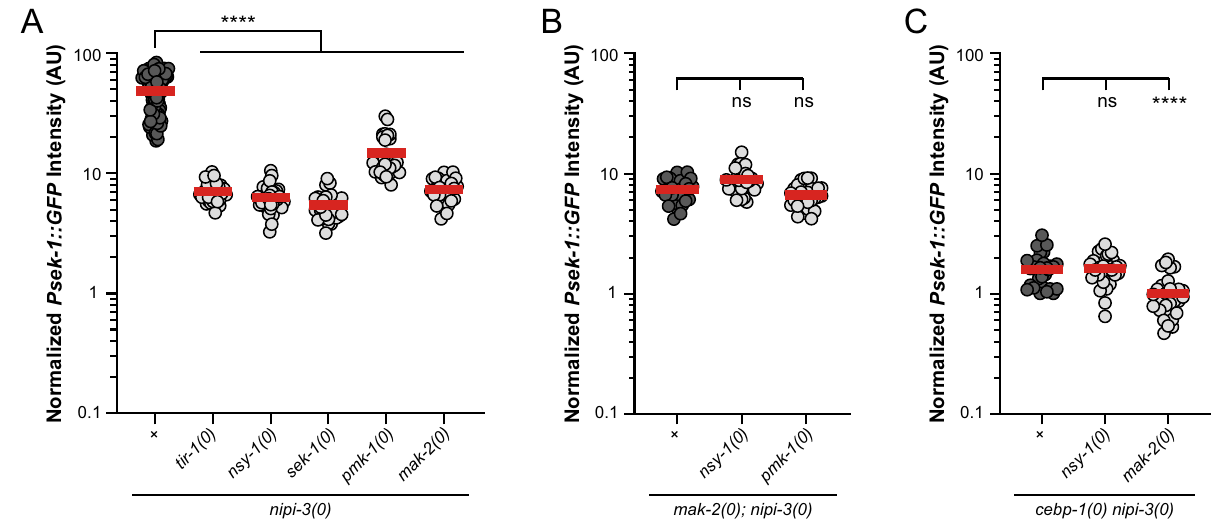
Figure 5. Transcriptional reporter of sek-1 suggests pmk-1 /MAPK and mak-2 /MAPKAPK feedback regulation of transcription of sek-1 . (A-C) Quantification of Psek-1::GFP expression in animals 36 h post egg laid. Null alleles in this figure are nipi-3(ju1293) , cebp-1(tm2807), tir-1(qd4), nsy-1(ok593), sek-1(km4), pmk-1(km25), and mak-2(ok2394) . Statistics Kruskal–Wallis one-way ANOVA with Dunn’s multiple comparisons test. ns , not significant, ** P < 0.01, **** P < 0.0001. ( A ) Knockout of nipi-3 substantially increases Psek-1::GFP expression, which is significantly reduced by null mutations to any member of this MAPK pathway . pmk-1(0) is significantly weaker at suppressing Psek-1::GFP expression in comparison to all other knockouts. Psek-1::GFP expression in mak-2(0); nipi-3(0) is not significantly different than nsy-1(0), tir-1(0), or sek-1(0) with nipi-3(0), indicating that it is likely not downstream of pmk-1 in this pathway regulating sek-1 expression. ( B ) Compound mutants of mak-2(0); nipi-3(0) with nsy-1(0) or pmk-1(0) do not confer greater Psek-1::GFP suppression than each of the single mutants. ( C ) Compound mutants of cebp-1(0) nipi-3(0) with nsy-1(0) or mak-2(0) do not confer greater Psek-1::GFP suppression than each of the single